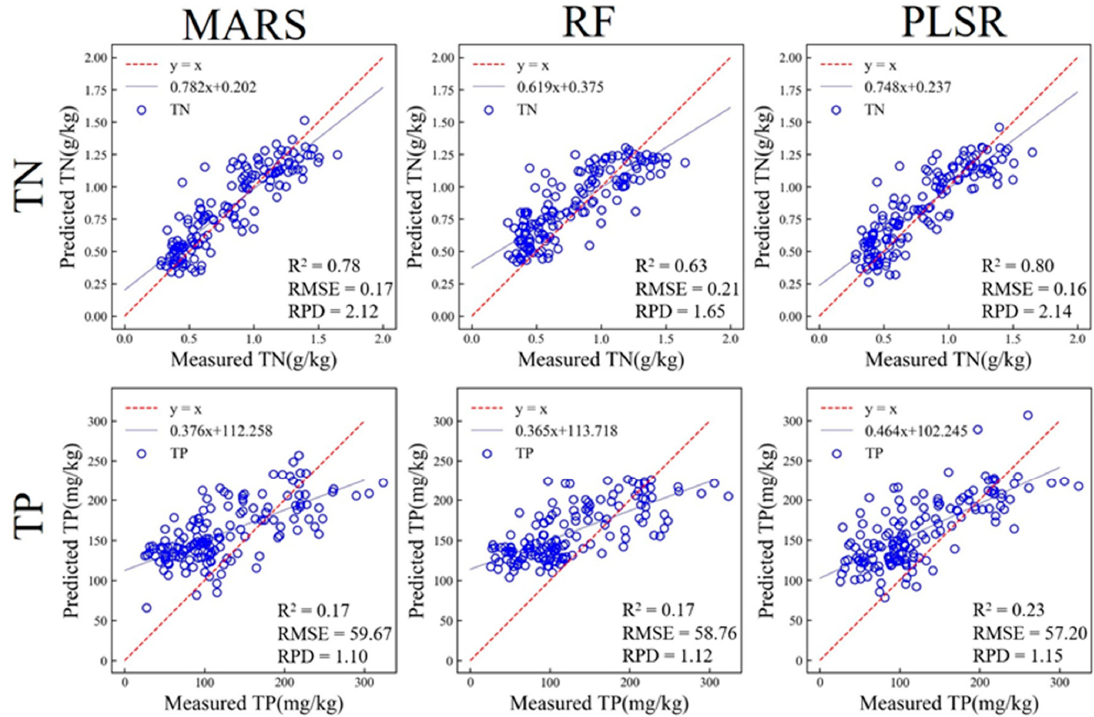
Figure 6. Sca tt er plot of predicted soil TN and TP based on in situ vis-NIR. Figure 6. Scatter plot of predicted soil TN and TP based on in situ